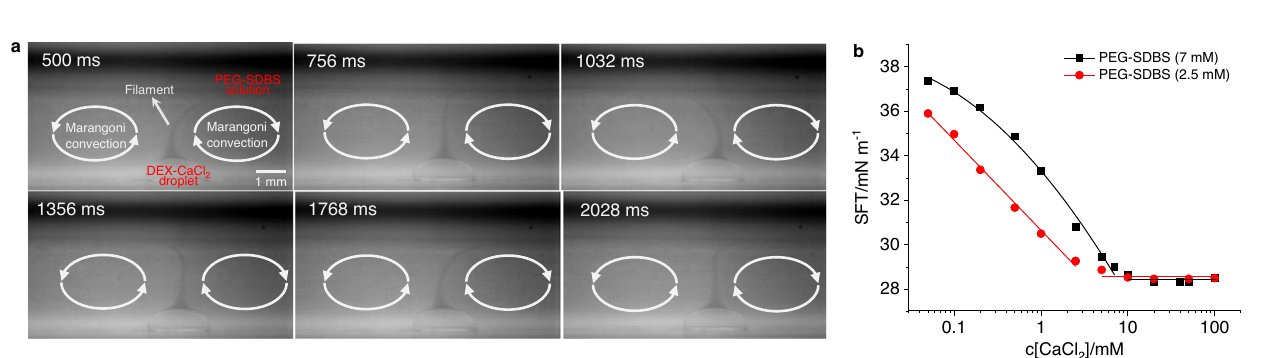
density1.05 – 1.15g/cm 3 )wereadded to thePEG-SDBSsolution tovisualize the fl ow. Images were taken from Supplementary Movie 1. b Black line: SFT vs. c[CaCl 2 ] for PEG-SDBS (7mM). SFT with no CaCl 2 is 37.9 mN/m. Red line: same, but for PEG- SDBS (2.5mM). SFT with no CaCl 2 is